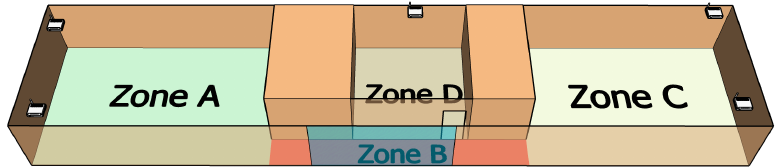
Figure 8. Experimental environment layout. White squares denote the location of APs.